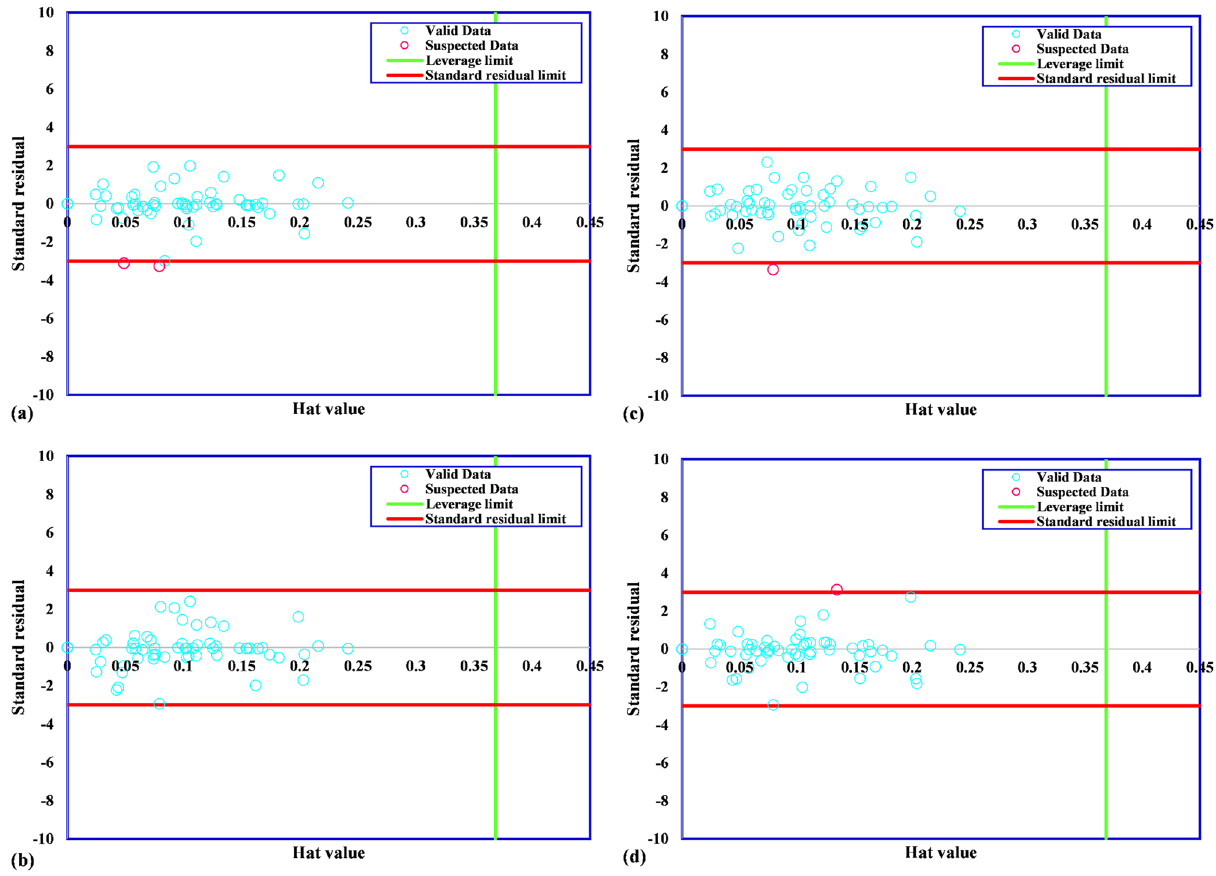
Figure 2. Detection of outliers for GPR models including ( a ) exponential, ( b ) squared exponential, ( c ) rational quadratic, ( d )